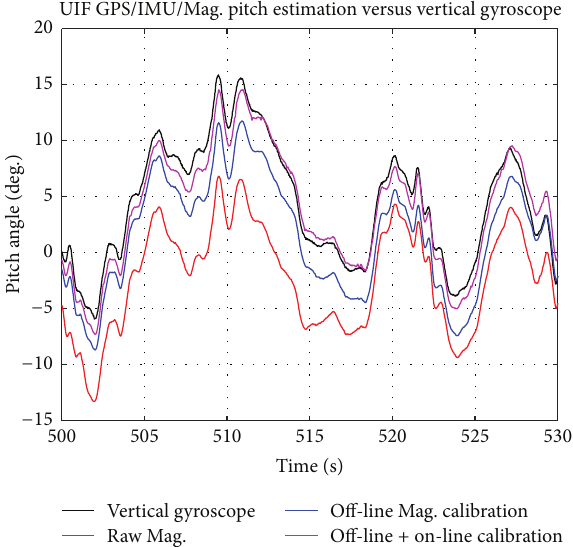
Figure 4: GPS/IMU/Mag. sensor fusion with raw, off-line calibra- tion, and a two-stage off-line/on-line